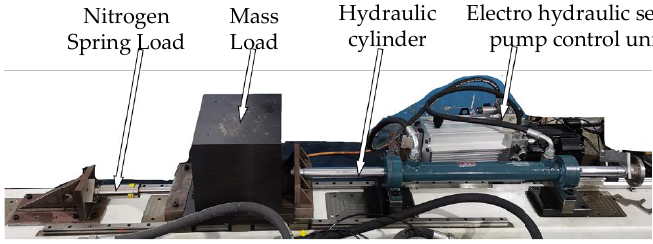
Figure 5. Hydraulic part of experimental platform.